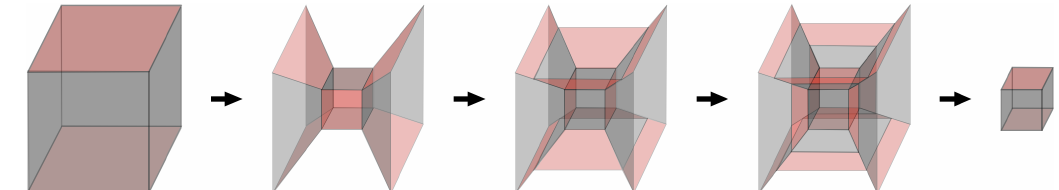
Figure 16 . Three consecutive cube moves on a single cubic brick amount to the identity (the relative sizes of the cubes are irrelevant). Massive fields are preserved during triality transformation and are integrated out at the last step.